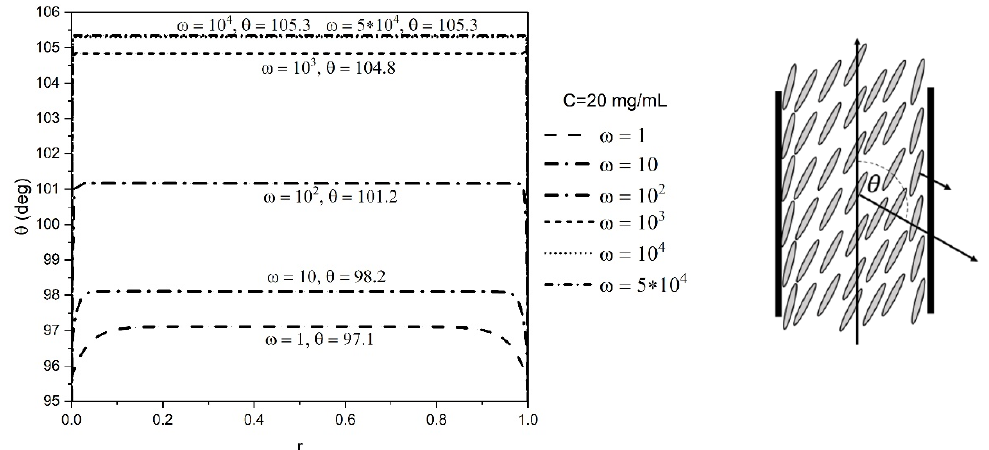
Figure 5. Orientation profiles for 20 mg/mL GO dispersion across the dimensionless gap at different dimensionless shear rates using the EL theory.